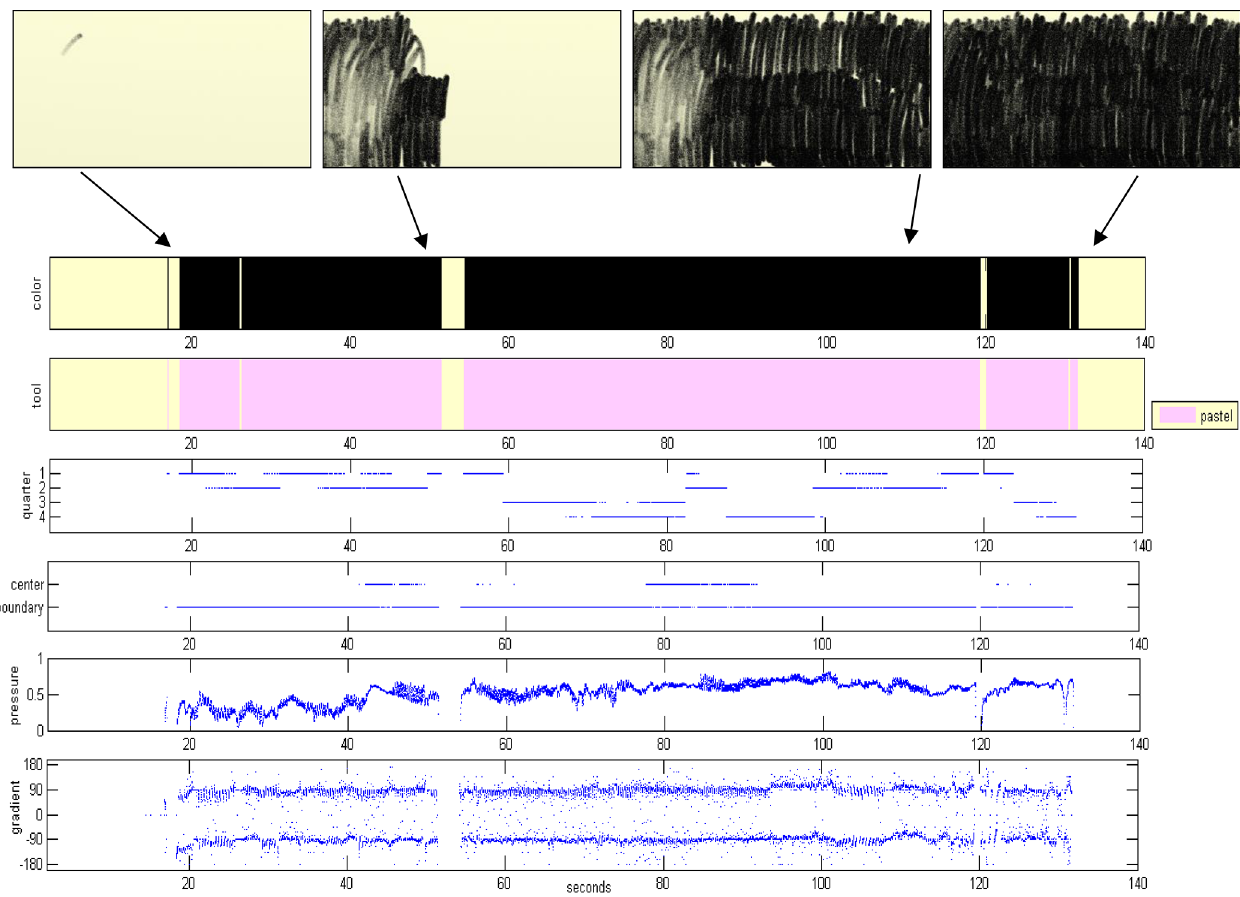
Fig 10. Visualization of an art making process (a negative feeling). A visual report of the creation process dynamics of an artwork imaging a negative